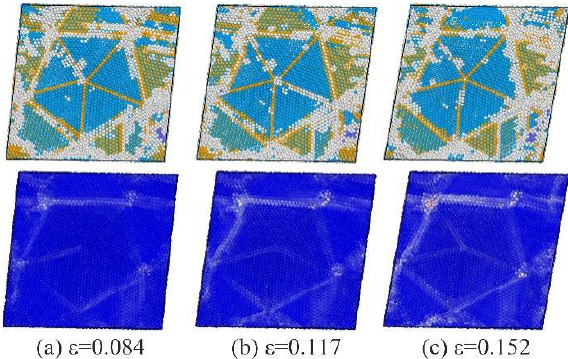
Figure 5. Snapshots of several strain points. Atoms are colored based on both the structure type and atomic strain of each atom. FCC structures are colored blue, and HCP structures are colored orange, other atoms are colored gray. Where ε is the strain rate, ( a ) ε = 0.084, ( b ) ε = 0.117, ( c ) ε = 0.152.